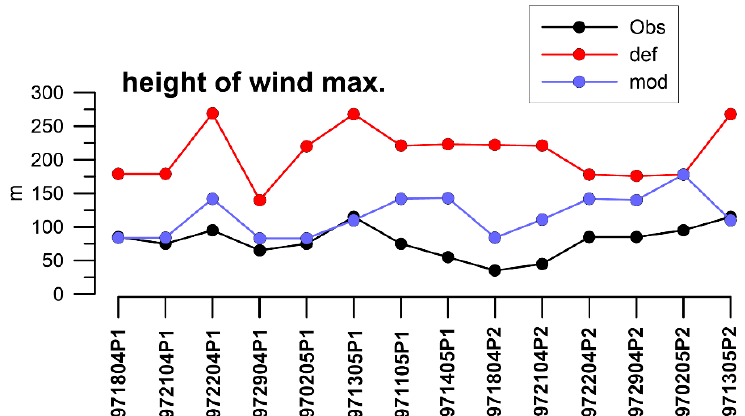
Figure 14. Height of the wind maximum from aircraft profiles (black) and simulations (def: red, mod: blue) for all KABEG flights (see Table 1).